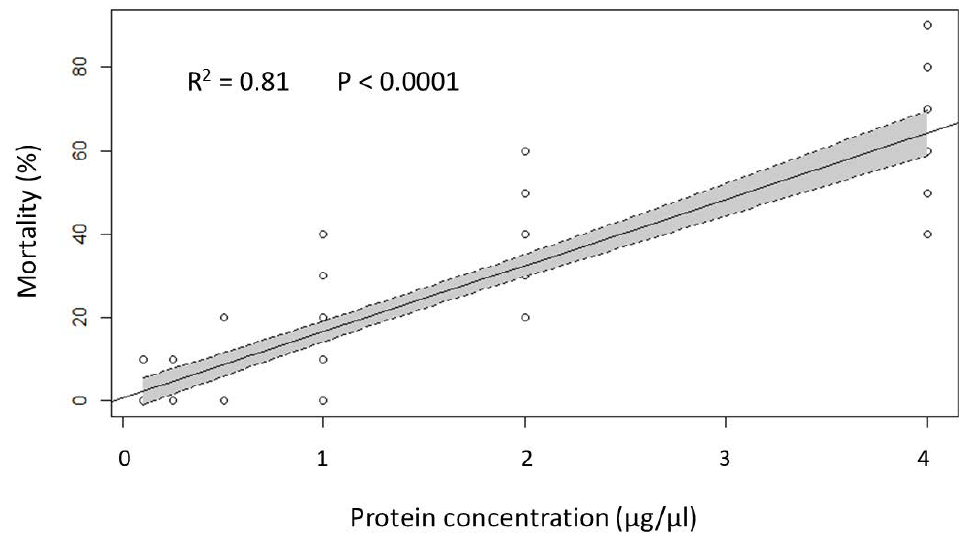
Figure 5. Relationship between fly mortality and protein concentration of the released cell wall multilayer (RWL) fraction of B. laterosporus (linear regression plot with shaded areas representing 95% confidence intervals).